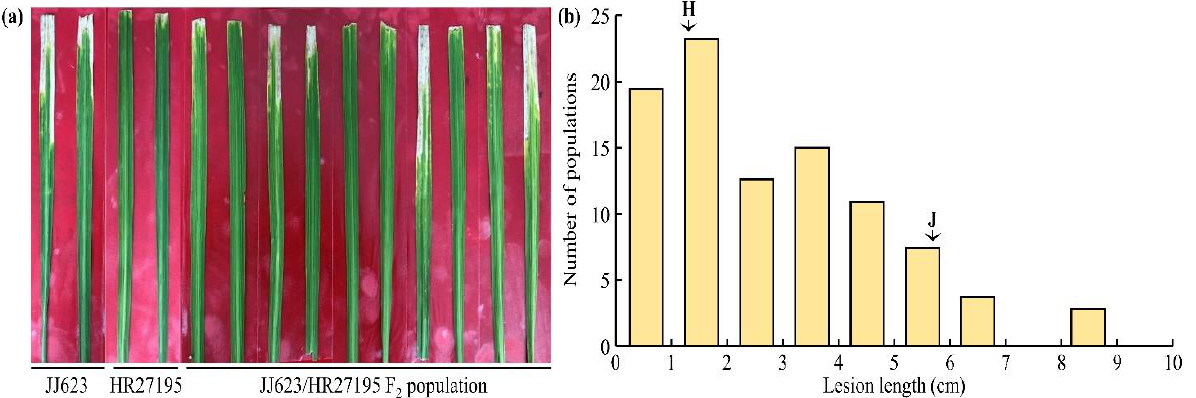
Figure 1. Frequency distribution and symptoms of lesion length induced by Xanthomonas oryzae pv. oryzae ( Xoo ) in the F 2 line derived from JJ623/HR27195 crossing, JJ623, and HR27195. ( a ) Disease phenotypes after Xoo inoculation in JJ623, HR27195, and JJ623/HR27195 F 2 lines by Xoo . JJ623 is moderately resistant to Xoo infection, but HR27195 is strongly resistant to Xoo. However, various phenotypes from susceptible to resistant were investigated in the JJ623/HR27195 F 2 line. ( b ) The lesion length of JJ623 shows a moderate resistance of 5.6 cm and that of HR27195 a strong resistance of 1.3 cm. When Xoo was infected on the JJ623, HR27195 and JJ623/HR27195 F 2 lines, various lesion lengths were investigated for each line. For the normal distribution, each of the resistance phenotype, moderate resistance phenotype, and susceptibility phenotype showed a left-biased normal distribution. H: HR27195, J: Table 2. Genetic analysis of the resistance response using lesion length for pathotype of Xoo K3a, a bacterium that induces BB of the F 2 line derived between JJ623 and HR27195. Number of Cross Resistance